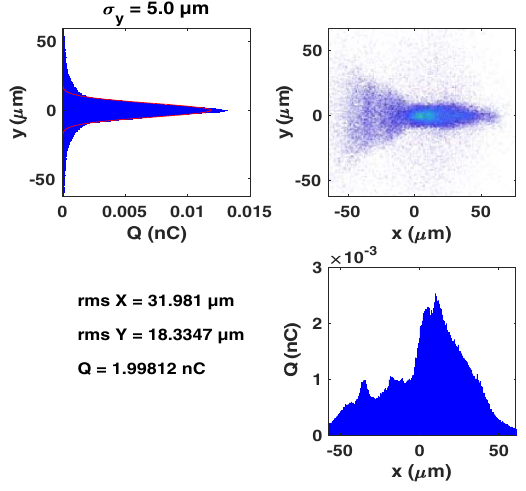
FIG. 5. Transverse projections of the 2-nC electron bunch tracked to sector 20 at maximum compression.